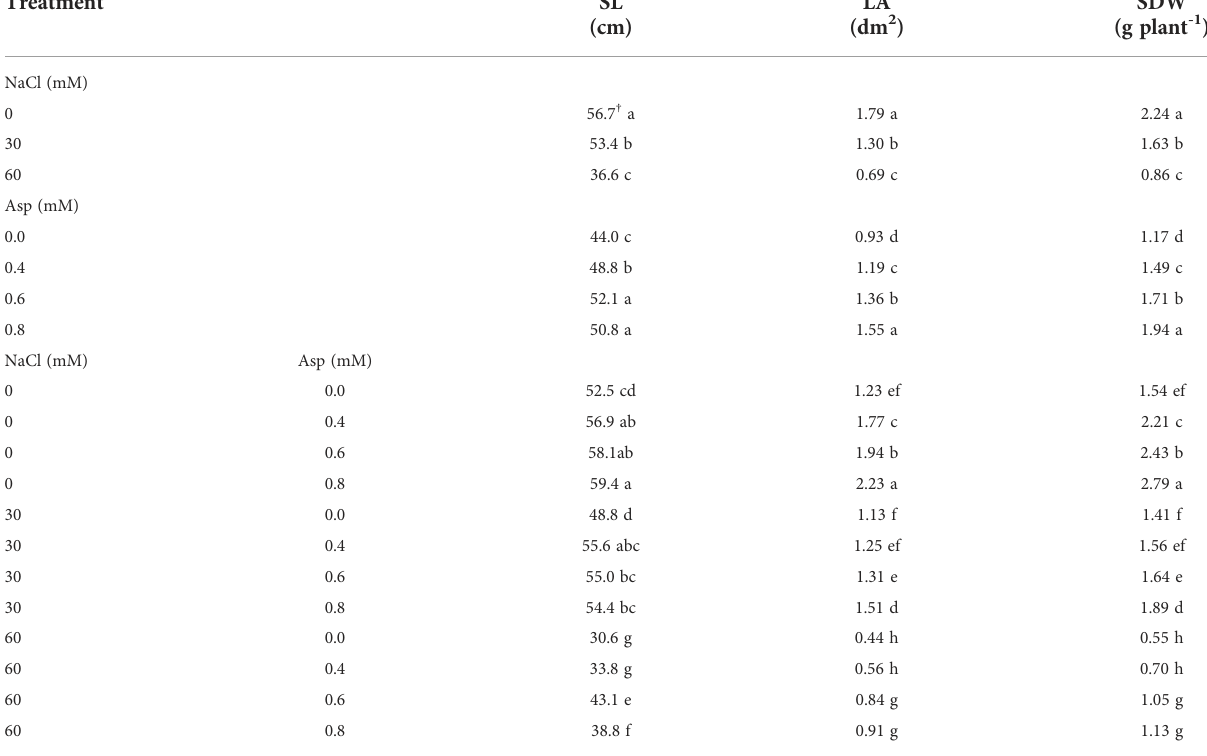
TABLE 7 Effect of aspartic acid (Asp) on shoot length (SL), total leaves area per plant (LA), and shoot dry weight per plant (SDW) in wheat plants grown under salt stress (NaCl) for 60 days. Treatment